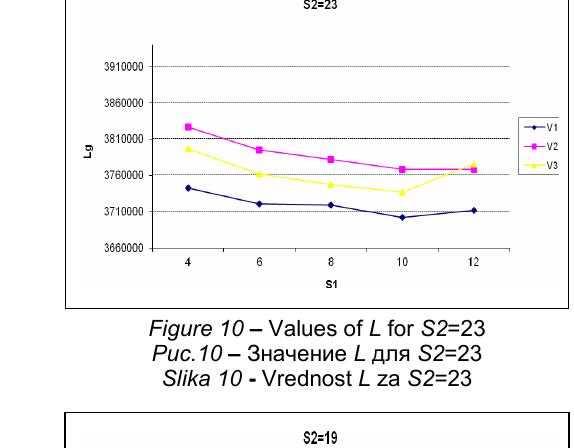
Figure 10 – Values of L for S2 =23